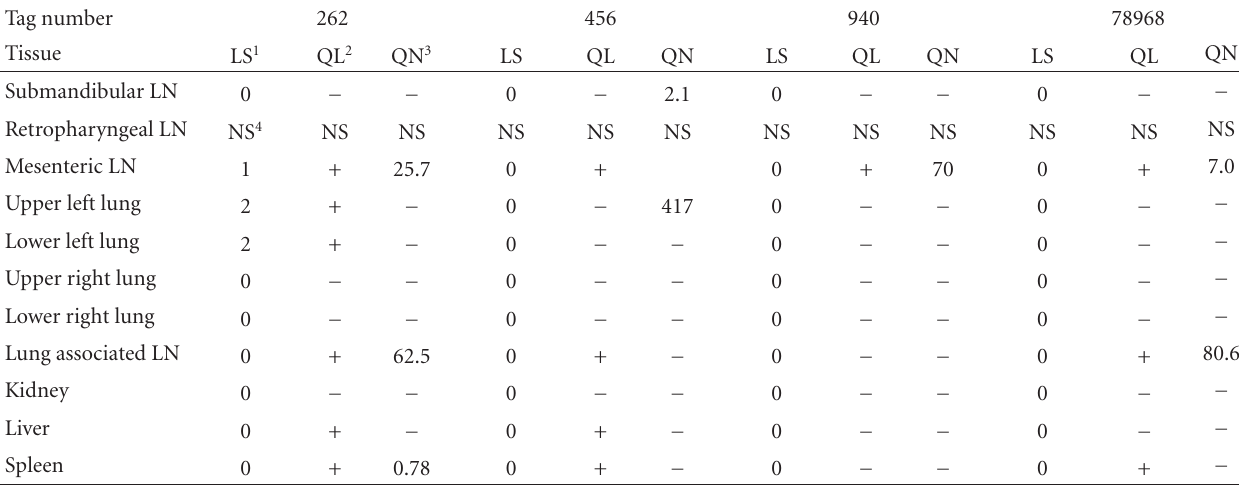
Table 3: Isolation of M. bovis from a range of tissues taken from 4 ferrets infected with 0 . 8 × 10 2 CFU and examined postmortem at 20 weeks post